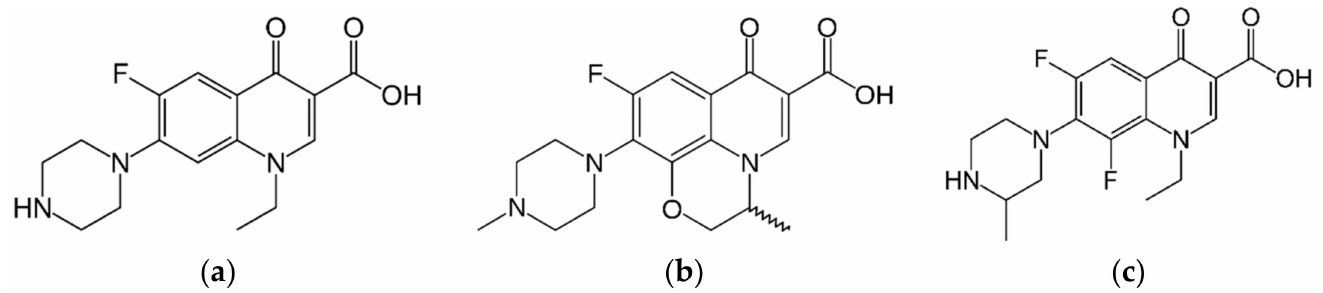
Figure 4. Chemical structures of the fluoroquinolones: ( a ) norfloxacin; ( b ) ofloxacin; ( c )